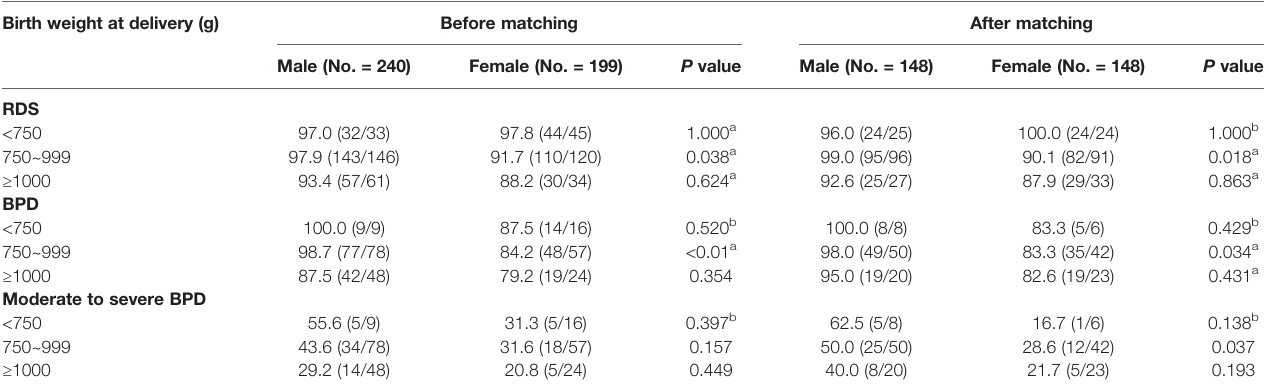
TABLE 4 | The effects of birth weight on the incidence of respiratory complications in male and female EPIs (%[diagnosed No./assessed No.]). Birth weight at delivery (g) Before matching After